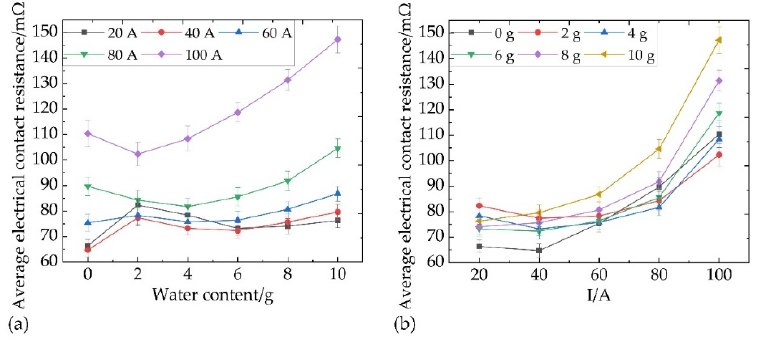
Figure 5. Effect of water content on the AECR of C-Cu contacts: ( a ) under different currents; ( b ) 280